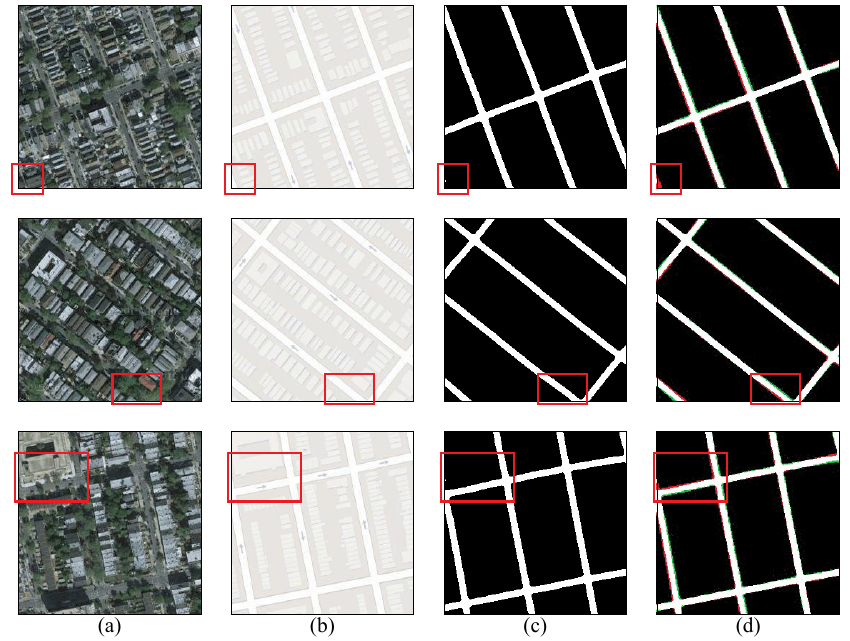
Figure 13. The analysis about the FP and FN: ( a ) remote sensing image, ( b ) mapping image, ( c ) the GT’s binary image, and ( d ) synthesis binary image.